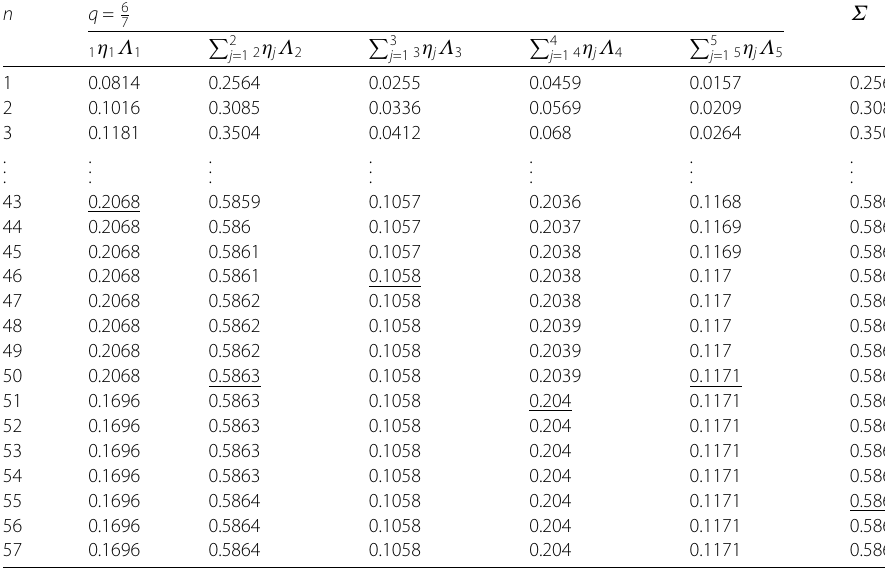
Table 6 Some numerical results of Σ in Example 1 for q = 6